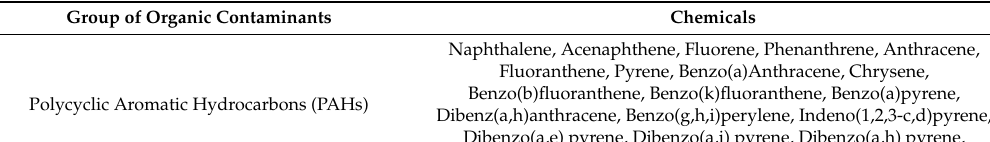
Table 2. List of organic contaminants examined in the nine piezometers